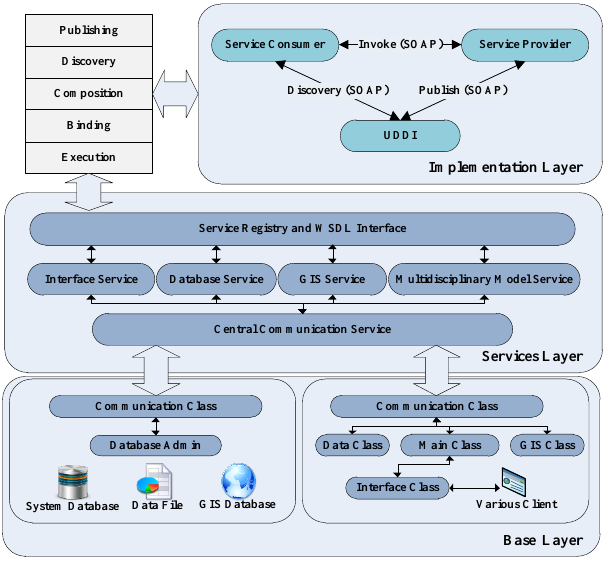
Fig. 3. Loose-coupling framework for the model-driven method.